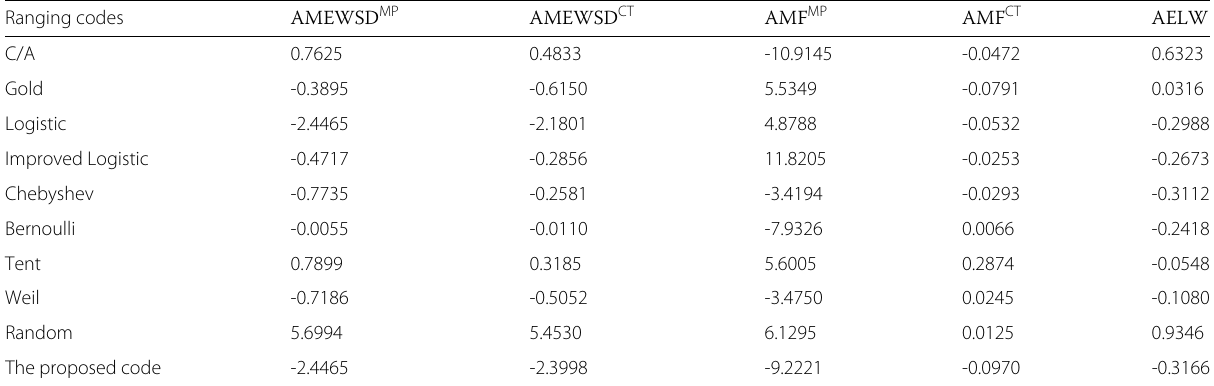
Table 3 The comparison of performance indexes for various ranging codes through weighting (%) Ranging